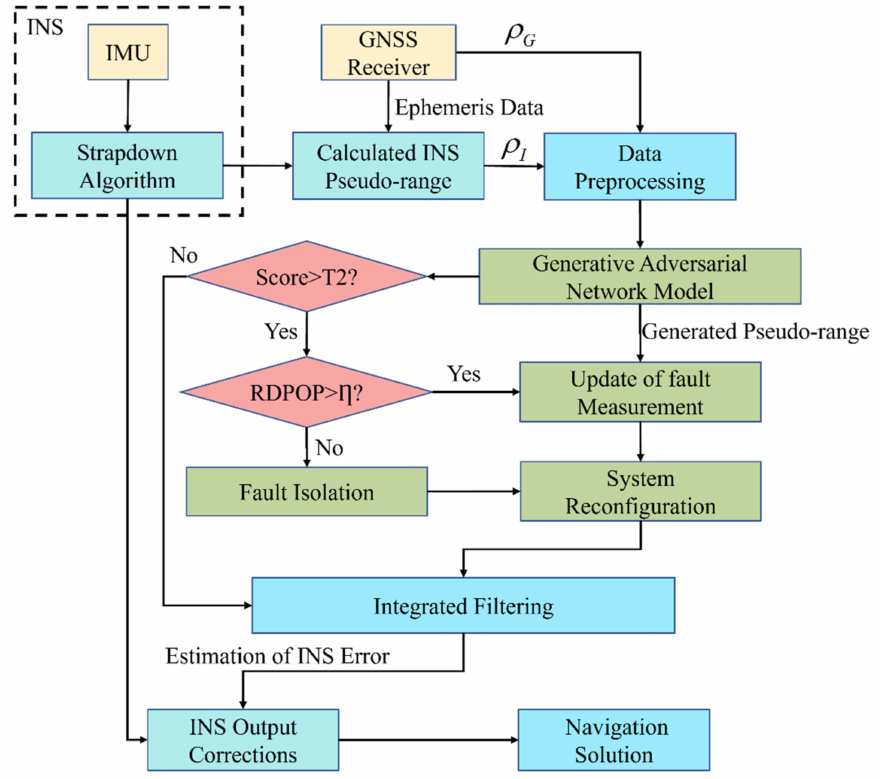
Figure 5. The architecture of GAN-FDSR.